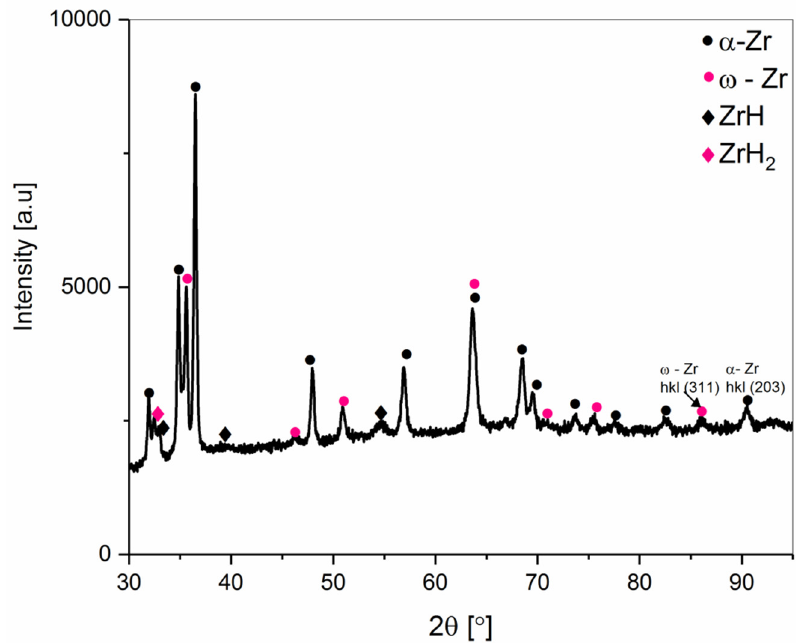
Figure 10. The X-ray diffraction pattern for the compacted Zr 2 powder with the marked peak accepted as a reference point for stress measurement.